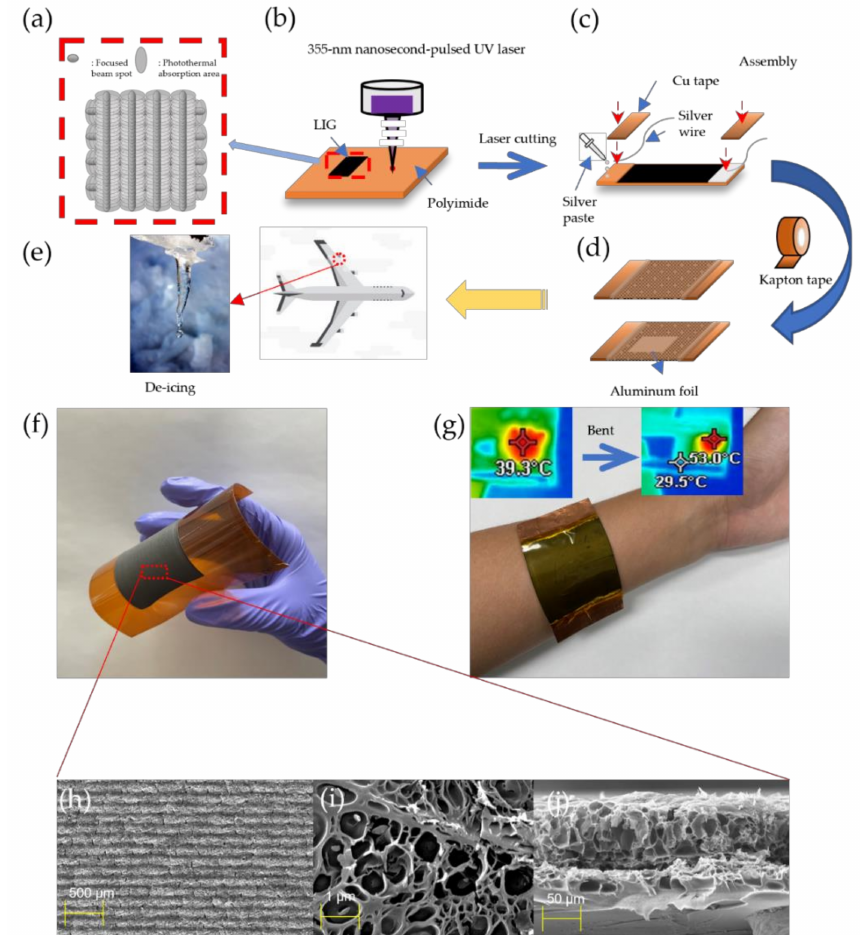
Figure 1. Fabrication process of proposed LIG heater: ( a ) illustration of laser pulse spot, ( b ) 355 nm pulsed UV laser irradiation onto PI:LIG heater platform ( c ) LIG heater sealed with silver paste and wire and Cu tape, ( d ) encapsulation of LIG heater with Kapton tape, ( e ) schematic illustration of LIG heater pad for de-icing ( f ) actual photograph of flexible LIG pattern, ( g ) LIG heater pad for wearable device. FE-SEM images of LIG pattern’s ( h ) top view, ( i ) interior, and ( j )